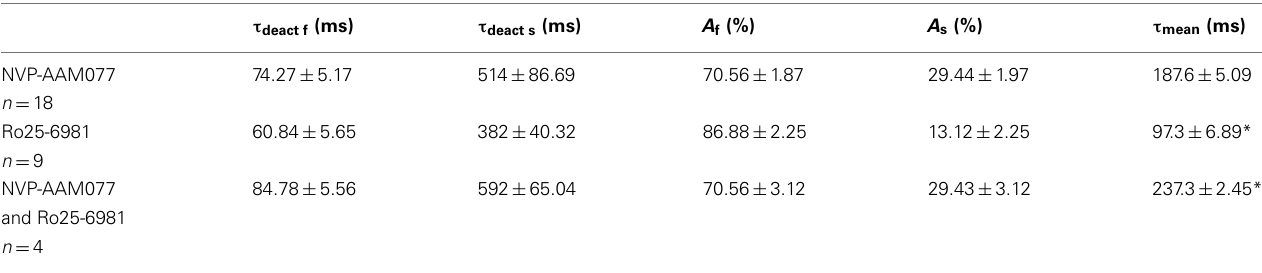
Table 3 | Decay time-constants of the NVP-AAM077-, Ro25-6981, and NVP-AAM077 + Ro-6981-resistant NMDAR currents in PCs.